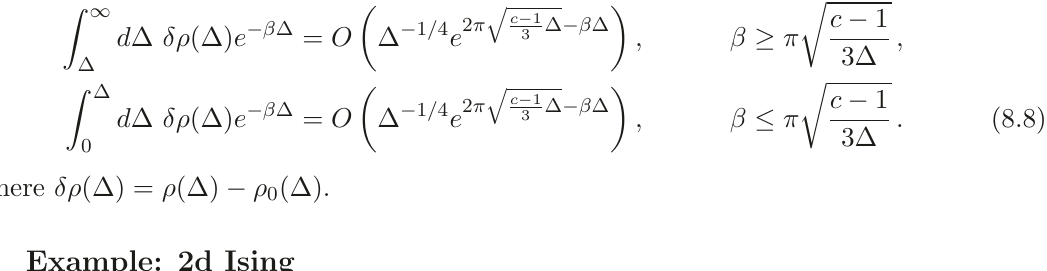
Figure 3 . F ρ (∆) (blue) and its smooth approximation F ρ in (1.8) we plot ( F ρ (∆) F ρ (∆))∆ 3 / 4 e − 2 π √ c 3 ∆ (inside the box). It is oscillating with a constant 0 − amplitude, as predicted by